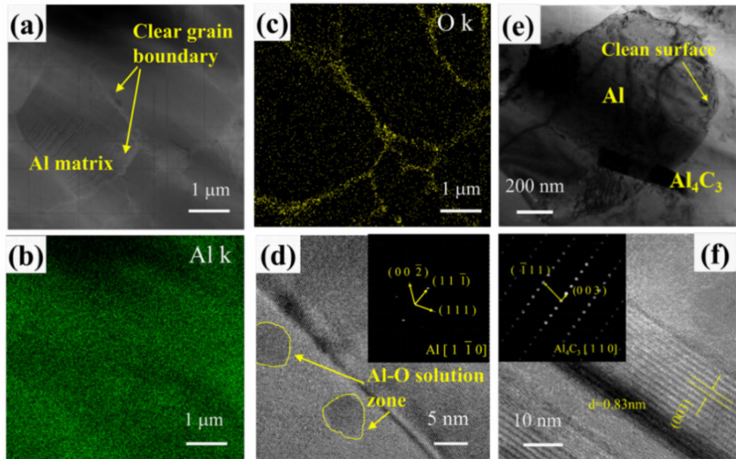
Figure 4. TEM images of the C-O / Al composites modified by 3 wt.% PVB consolidated at 630 ◦ C: ( a ) TEM image of the C-O / Al composite; ( b ) and ( c ) EDS mapping of Al and O distributions, respectively; ( d ) HRTEM of the Al-O microstructure and its selected area electronic di ff raction pattern; ( e ) TEM images of the Al 4 C 3 distribution in the Al matrix; and ( f ) HRTEM of the Al 4 C 3 microstructure and its selected area electronic di ff